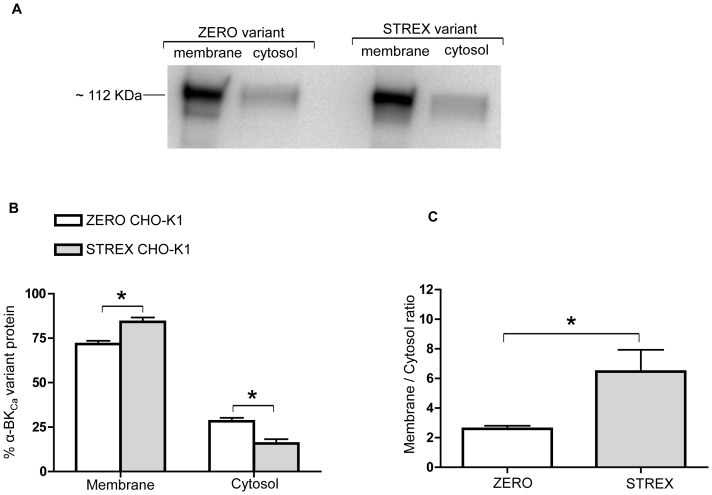
Membrane and cytosolic expression of ZERO and STREX variants in CHO-K1 cells.In a CHO-K1 cell culture system, the α-BKCa ZERO variant shows significantly lower cell surface expression than the STREX variant. Corresponding changes in the cytosolic fraction are observed. (A) Representative Western blot showing surface and cytosolic levels of α-BKCa protein in CHO-K1 cell culture system, transfected with either α-BKCa splice variants ZERO or STREX. (B) Summary of membrane vs cytosolic expression of transfected ZERO or STREX variants of α-BKCa channel protein (expressed as % of total α-BKCa protein). (C) Membrane to cytosolic expression ratio of ZERO and STREX α-BKCa proteins in transfected cultured CHO-K1 cells. Results are shown for n = 6 separate experiments and are presented as mean ± SEM (*P<0.05, unpaired t-test).